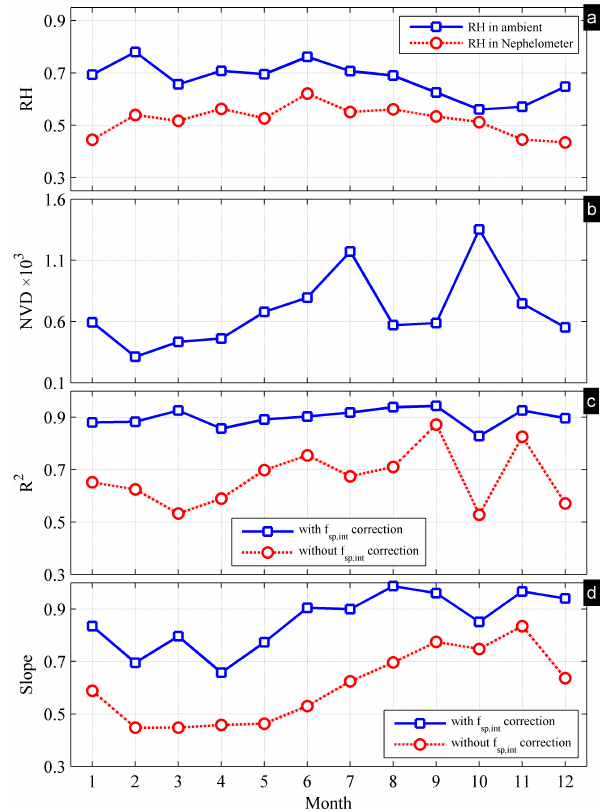
Figure 6 (a) Comparison of RH between ambient and inside Nephelometer; and the number of data samples (b), R 2 (c) and Figure 6. (a) Comparison of RH between ambient and inside the slope (d) of the linear regression between Nephelometer measured b sp and visibility derived b sp . nephelometer, the number of data samples (b) , R 2 (c) and slope (d) of the linear regression between the nephelometer-measured b sp and visibility-derived b sp .